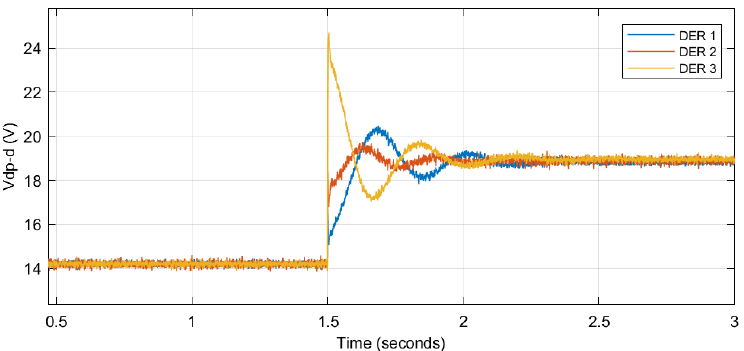
Figure 4. v dpd drop in voltage due to typical virtual impedance.